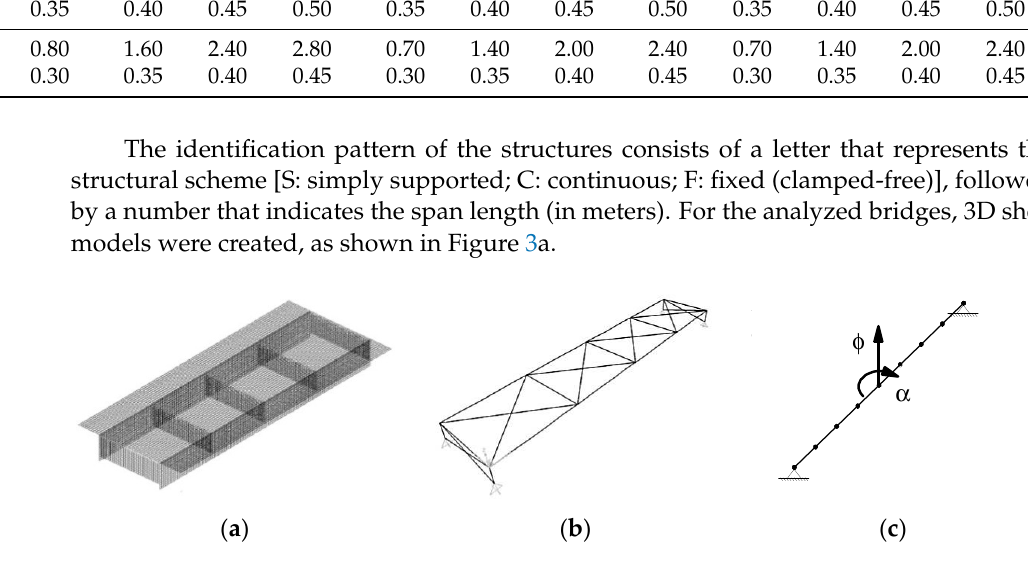
Figure 3. ( a ) Finite element model for the 30-m span simply supported bridge (S-30). ( b ) Equivalent grid model. ( c ) Stick model for dynamic analyses.